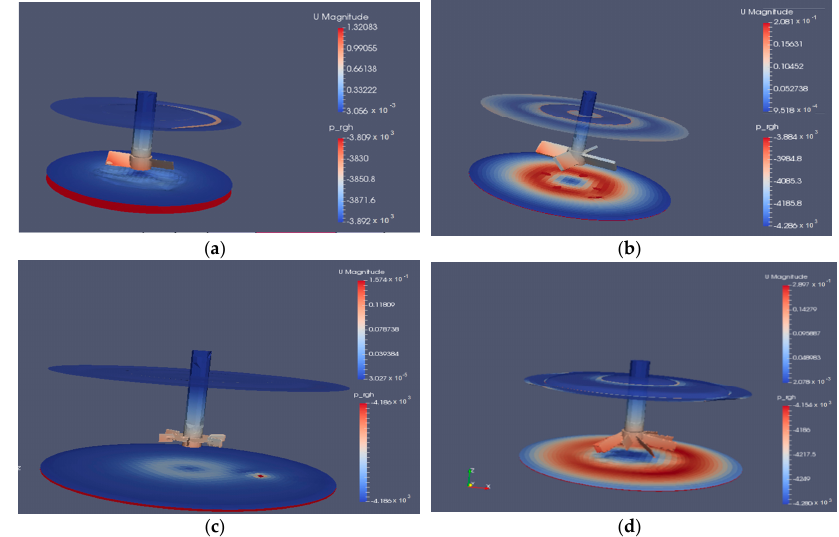
Figure 4. Isosurface comparing water interfaces for four di ff erent impellers including ( a ) a three-blade turbine, ( b ) a four-blade turbine, ( c ) a Rushton turbine, and ( d ) an eight-blade